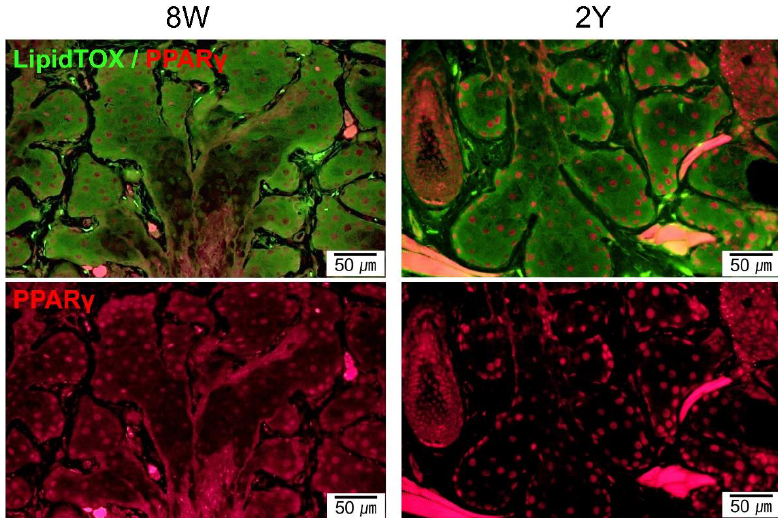
Figure 4. Representative images of coronal sections of the MGs stained with LipidTOX and PPARγ immunofluorescence (coronal section; 400×). Lipid droplets showed a similar distribution for 8W- and 2Y-old mice. PPARγ staining shows cytoplasmic and nuclear localization in 8W-old mice. In contrast, PPARγ staining shows predominant nuclear localization in 2Y-old mice.